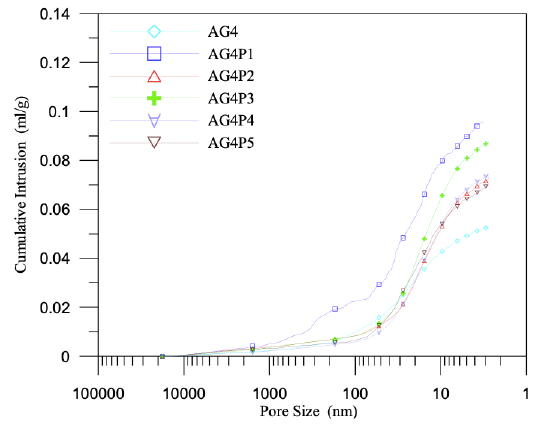
Figure 7. Relationship between the pore size and cumulative mercury intrusion of polyolefin fiber- reinforced concrete specimens (with slag).